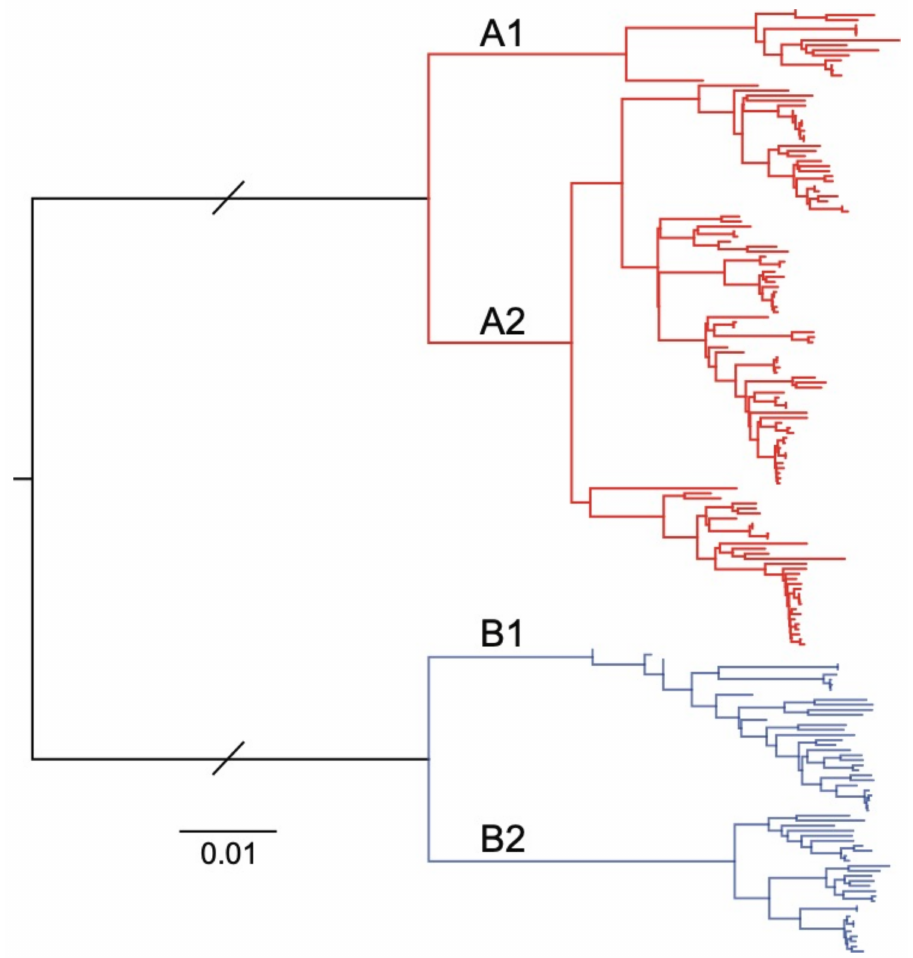
Figure 1. Neighbour-joining phylogenetic tree of 153 human metapneumovirus (HMPV) full-length or near-full-length genome sequences sourced from the National Center for Biotechnology Informa- tion (NCBI) GenBank database. The two major phylogenetic subtypes of HMPV are shown with different coloured branches, with known sublineages further differentiated by labelled branches (A1, A2, B1 and B2). The scale bar is proportional to the number of substitutions per site. The branch lengths between the A and B subtypes have been shortened for clarity. Table 1. Primer pairs used in this study to complete the near-whole-genome sequencing of human metapneumovirus.